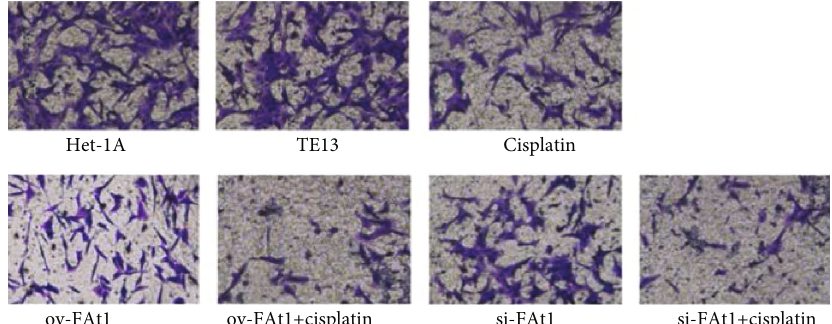
Figure 6: FAT1 inhibit the invasion of human esophageal cancer cell lines. Magni fi cation: 200 X. The Transwell method was used to detect the invasion ability of cells in each experimental group (het-1A cell line, TE13 cell line, TE13 cells treated with cisplatin, and TE13 cells transfected with ov-FAT1 and si-FAT or treated with cisplatin at the same time). The activation of FAT1 inhibits the invasion of human esophageal cancer cell lines. Magni fi cation: 200 X.